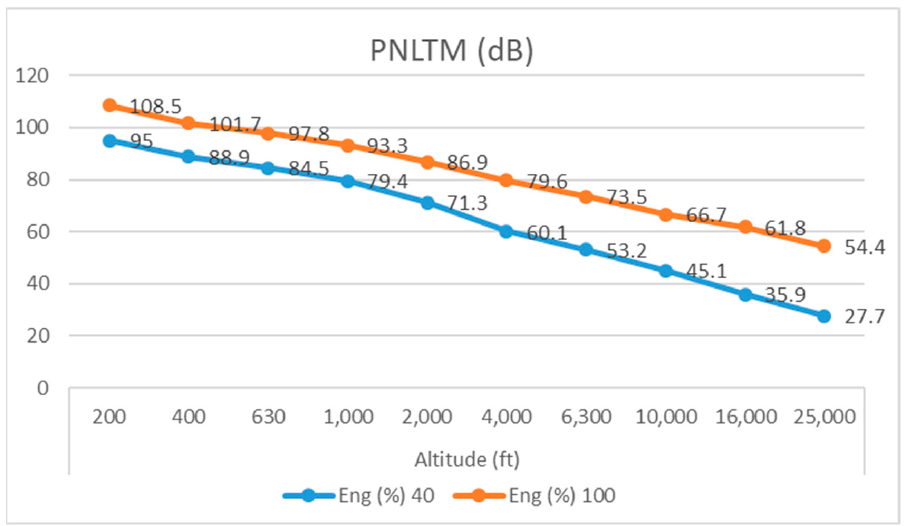
Figure 31. NPD curves, in terms of L AMax , for the ATR configuration.